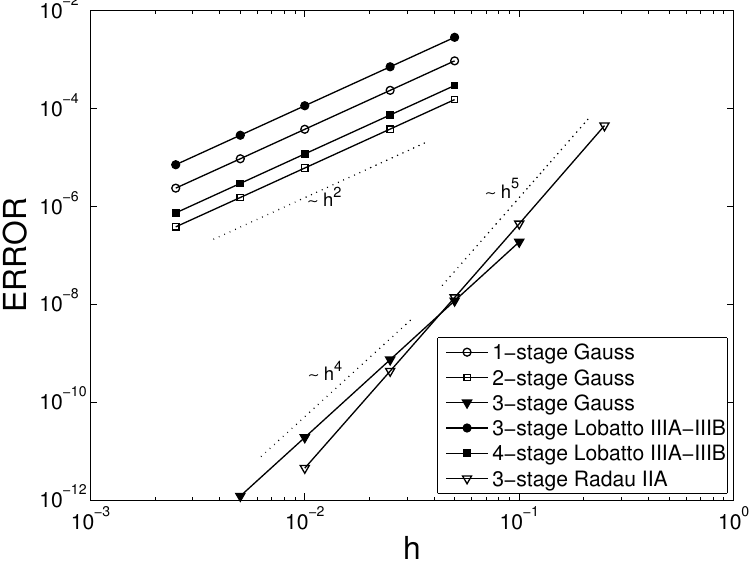
Figure 10. Convergence of several Runge–Kutta methods for the Lotka–Volterra